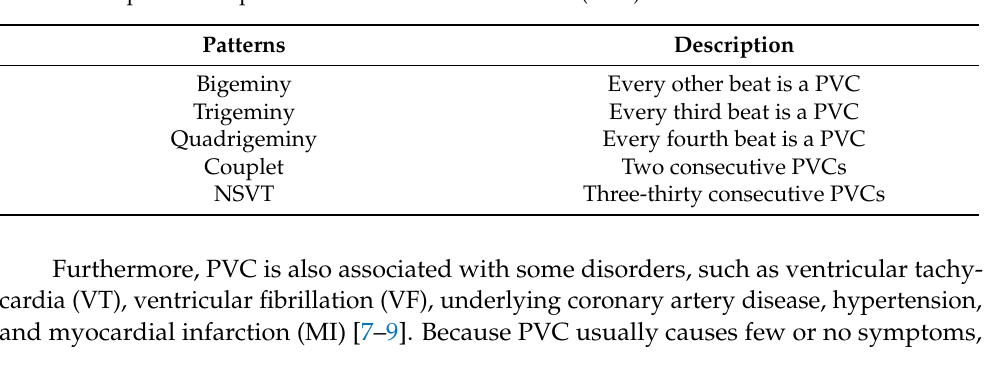
Table 3. The patterns of premature ventricular contraction (PVC)